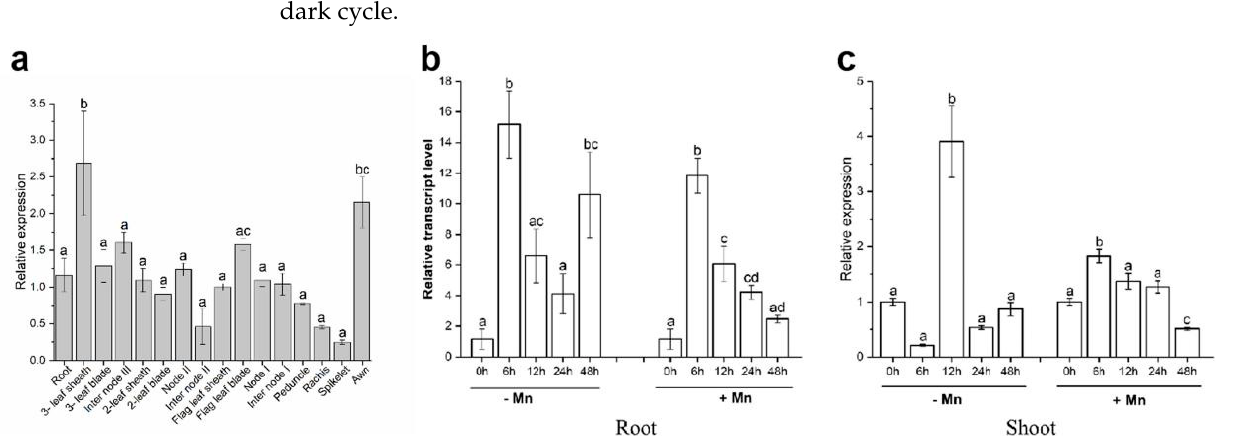
Figure 1. Tissue-specific expression patterns and expression profile of TuMTP8 under Mn exposure or Mn deficiency. ( a ) The transcript levels of TuMTP8 in 16 tissues were performed using qRT-PCR, and the gained data were calculated using the 2 − ∆∆ CT method with Ta2291 as the internal reference gene. n = 3. Significant differences are indicated by different letters (a, b, c, d). ( b , c ) The T. urartu seedlings were treated in ½ MS medium without or with 1 mM MnSO 4 for 6 h, 12 h, 24 h, or 48 h, 0 h as the control. The shoot ( b ) and root ( c ) were collected, respectively, and the expression levels of TuMTP8 in those parts were gained using the same methods as ( a ).